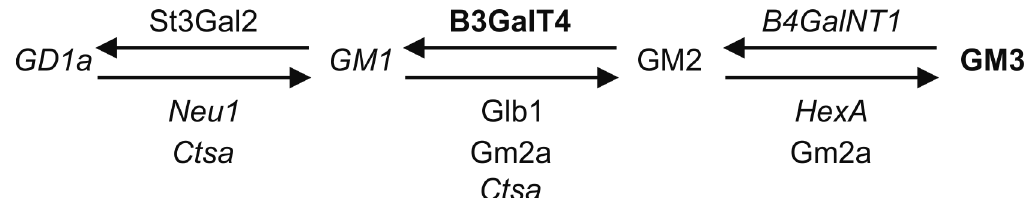
Figure 7. Summary of the alterations in gangliosides and their modifying genes in Cln3 Δ ex7/8 cells. Molecules found to be increased are shown in bold, those reduced in italics. Standard font depicts no change. Please see Discussion for details.